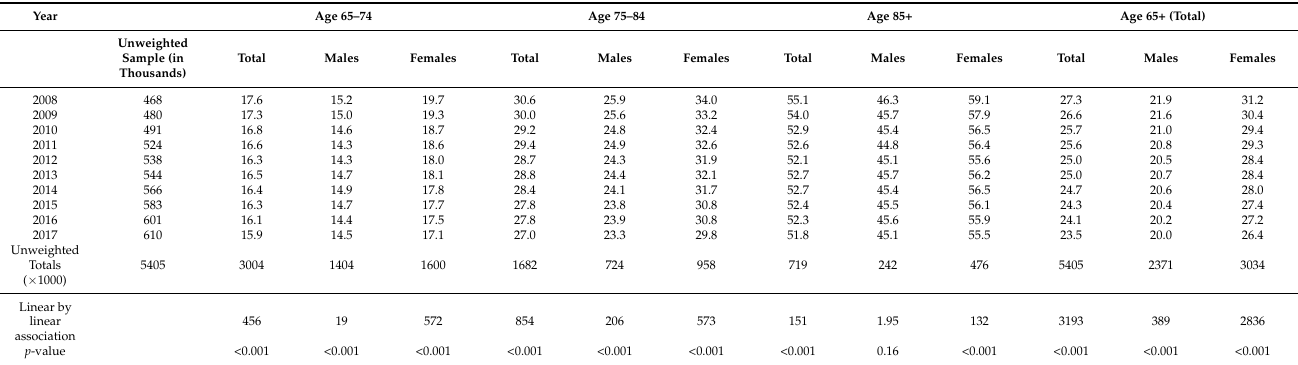
Table 3. Temporal trends in the prevalence of functional limitations (FLs 1 ) by decade (2008–2017), gender, and age cohort (ages 65–74, 75–84, and 85+; full sample aged 65 and over). Source: American Community Surveys Data (n = 5,405,135). (The prevalences are weighted; the sample sizes are unweighted and provided in